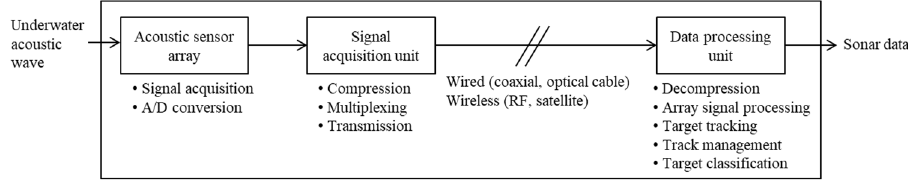
Figure 1. General structure of an underwater surveillance system based on acoustic sonars.